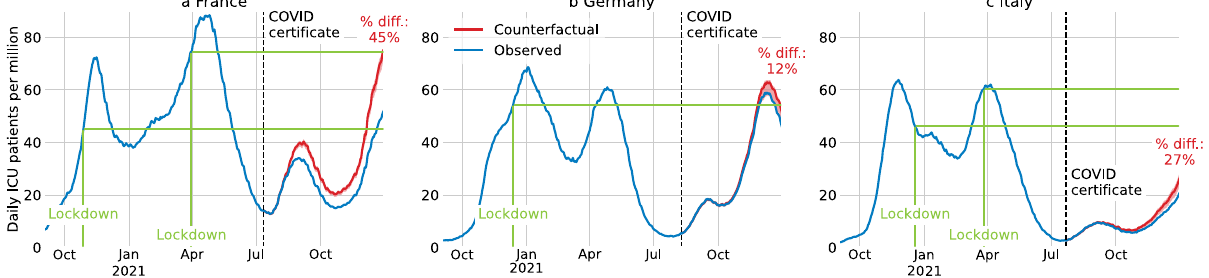
Fig. 4 Estimated ICU patients with and without COVID certi fi cates. For France ( a ), Germany ( b ), and Italy ( c ), daily COVID-19 patients in intensive care units (ICUs) per million (7-day rolling average) in the actual intervention deployment (blue) and in the no-intervention counterfactual scenario (red). The red shaded area is the 95% con fi dence interval centred around the main estimate. The counterfactual for France is based on an age-strati fi ed model. The other counterfactuals are not based on age-strati fi ed models due to unavailable data. Green lines indicate levels at which previous lockdowns were instated. The black dotted vertical line is the date of the announcement of the COVID certi fi cate.